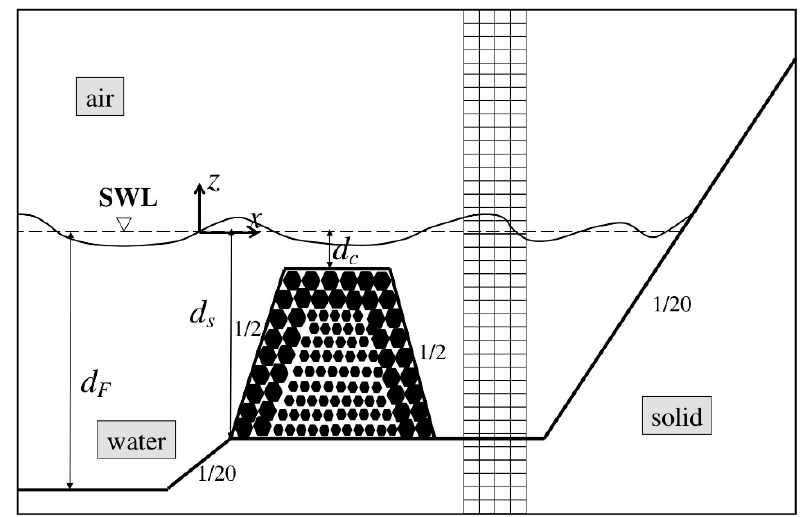
Figure 3. Sketch of the computational domain and part of the Cartesian grid, as well as definitions of the parameters for the numerical simulation of wave propagation over submerged permeable breakwater [13]. Note that the axes are not to scale. The distance from the wavemaker to the toe of the 1/20 slope is 19.3 d F , while the distance from the leeward toe of the breakwater to the toe of the absorbing beach is 4.5 d F .